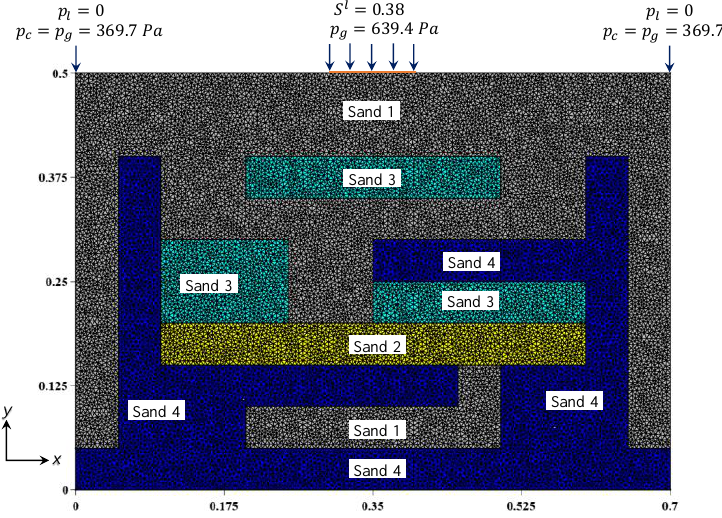
Figure 7. Configuration of heterogeneous sand lenses in parallel plate cell (see Kueper and Frind [19]).